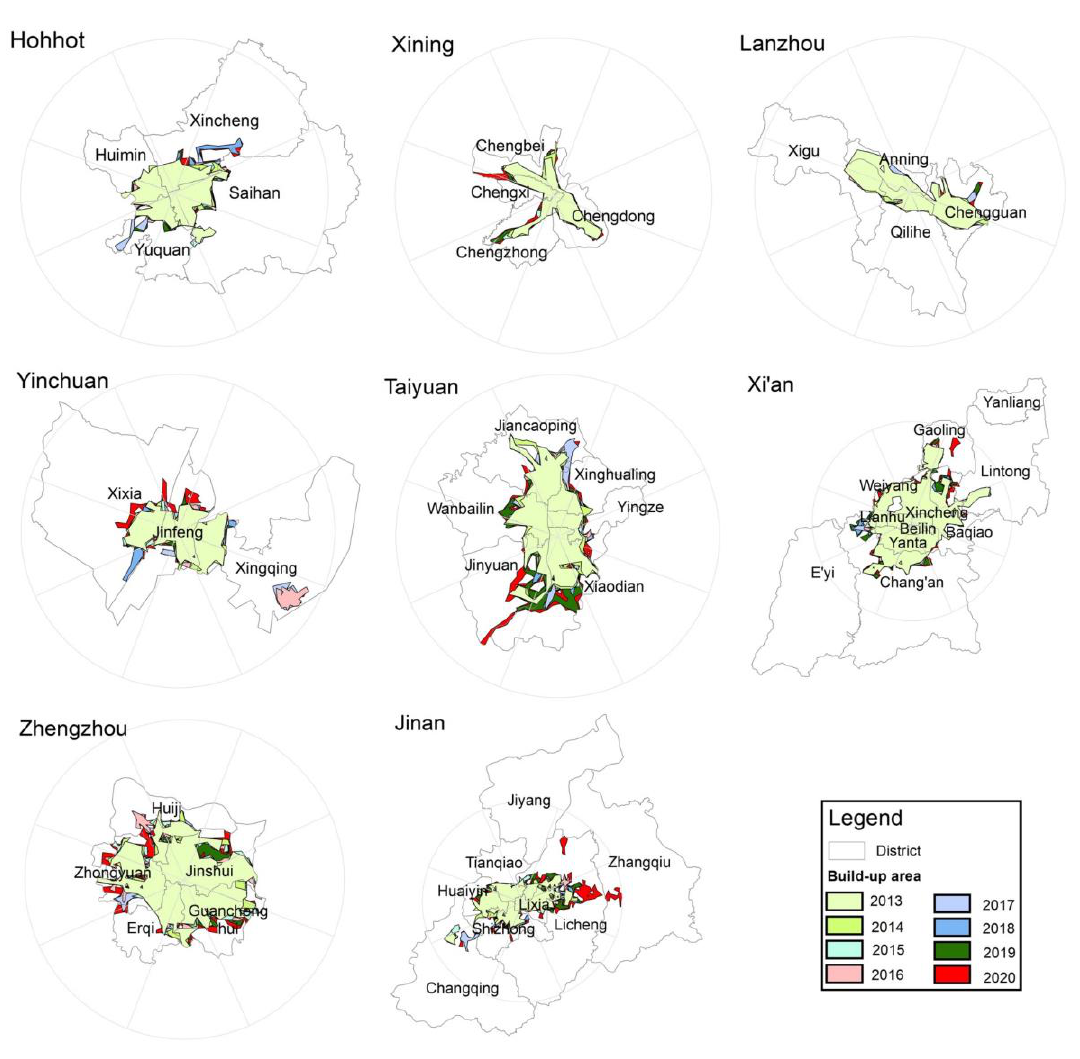
Figure 4. Spatial changes of urban built-up areas in the Yellow River Basin from 2013 to 2020. Table 2. Built-up areas of provincial capitals extracted from NTL from 2013 to 2020.